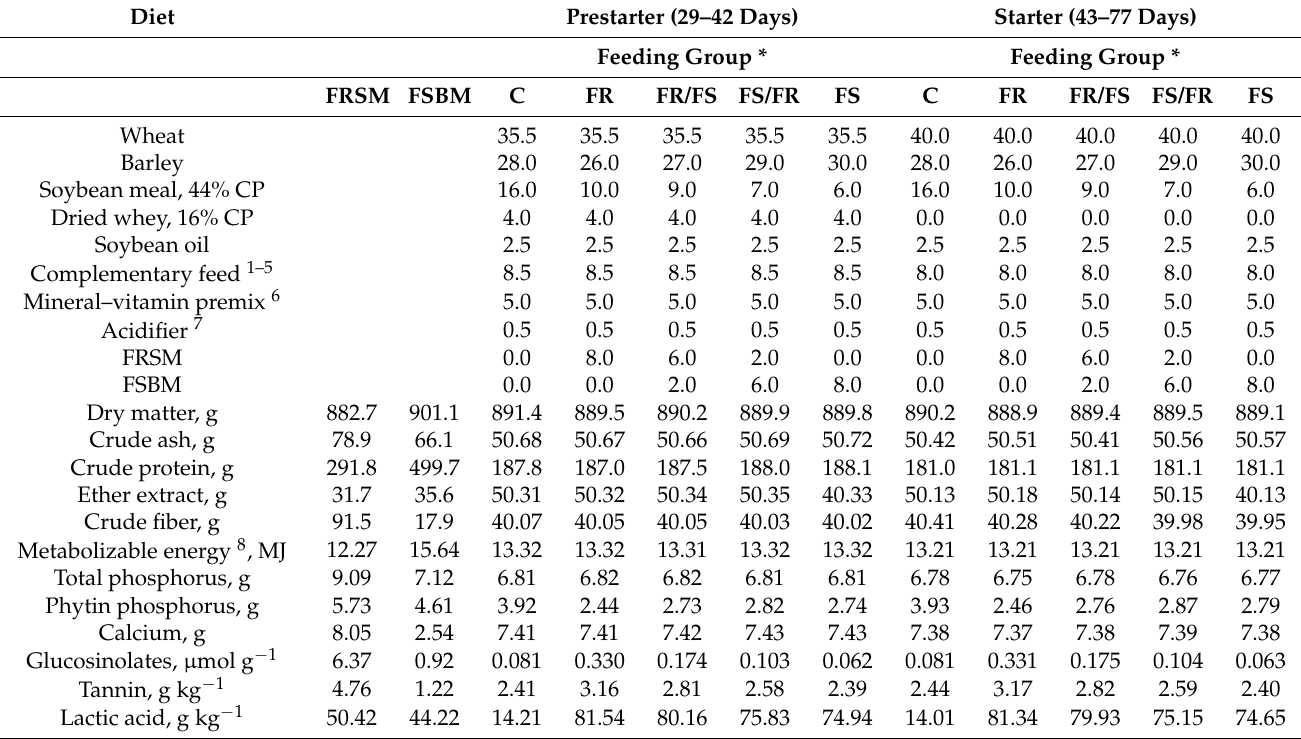
Table 1. Ingredient composition (% of air-dry matter) of piglet diets and content of analysed nutrients and bioactive substances in 1 kg of FRSM (n = 4) and FSBM (n = 4) and piglet diets (n =